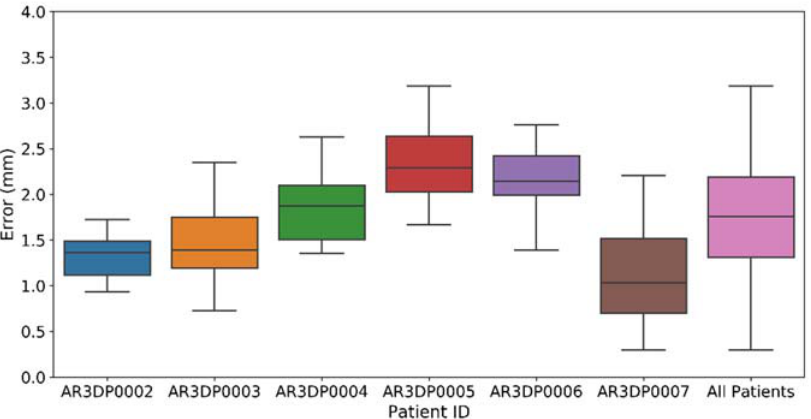
Figure 7. Surgical Guide Placement Error obtained for each patient phantom. The upper and lower limits for each box represent the first and third quartile of the dataset, and the middle line indicates the median. The whiskers stand for the highest and lowest values (±1.5 times the standard deviation).